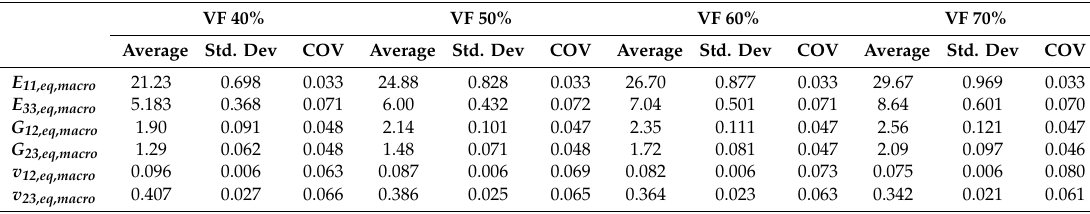
Table 9. MCS result of the